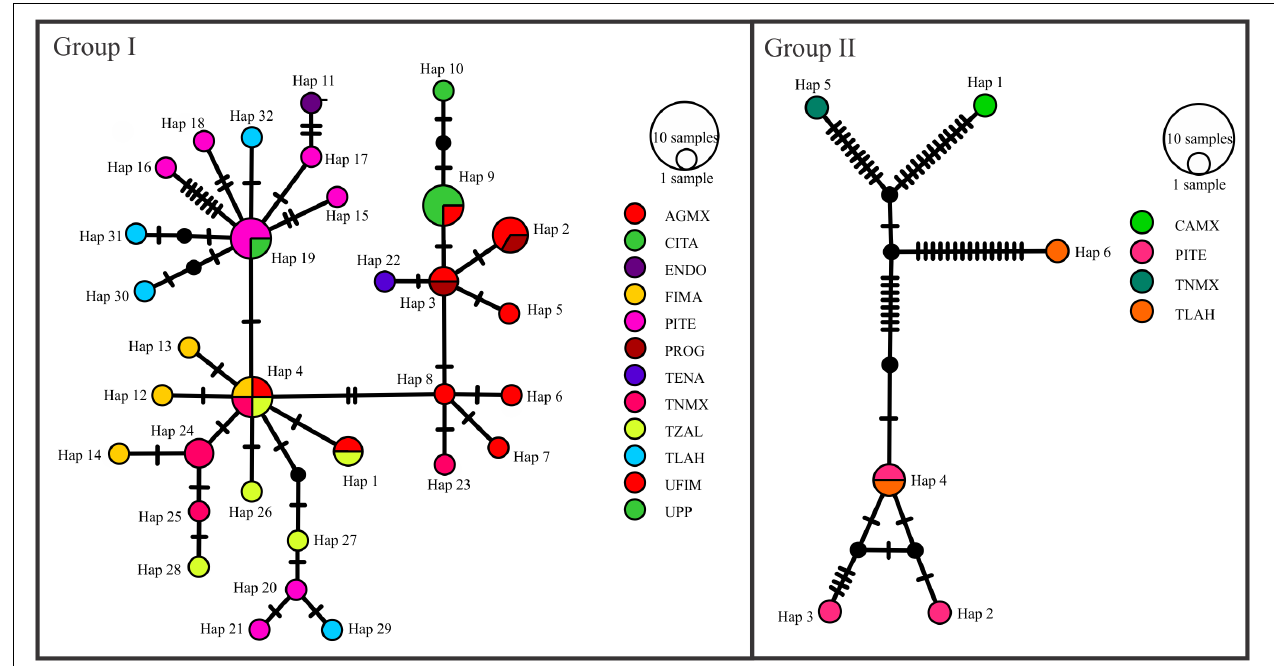
FIGURE 3 | Haplotype networks constructed using the Media Joining Network method for the concatenated ITS, β -tubulin, Eap1 nuclear genes, and mitochondrial gene LAGLIDADG. The networks shown for genetic groups I and II had 27 and 6 haplotypes, respectively, all identified from isolates of S. reilianum collected in cornfields at different sites in Valle del Mezquital. The diagonal lines to the connections between haplotypes represent the number of mutations; colors represent the geographic localities. Circle size is proportional to the frequency of the different haplotypes.